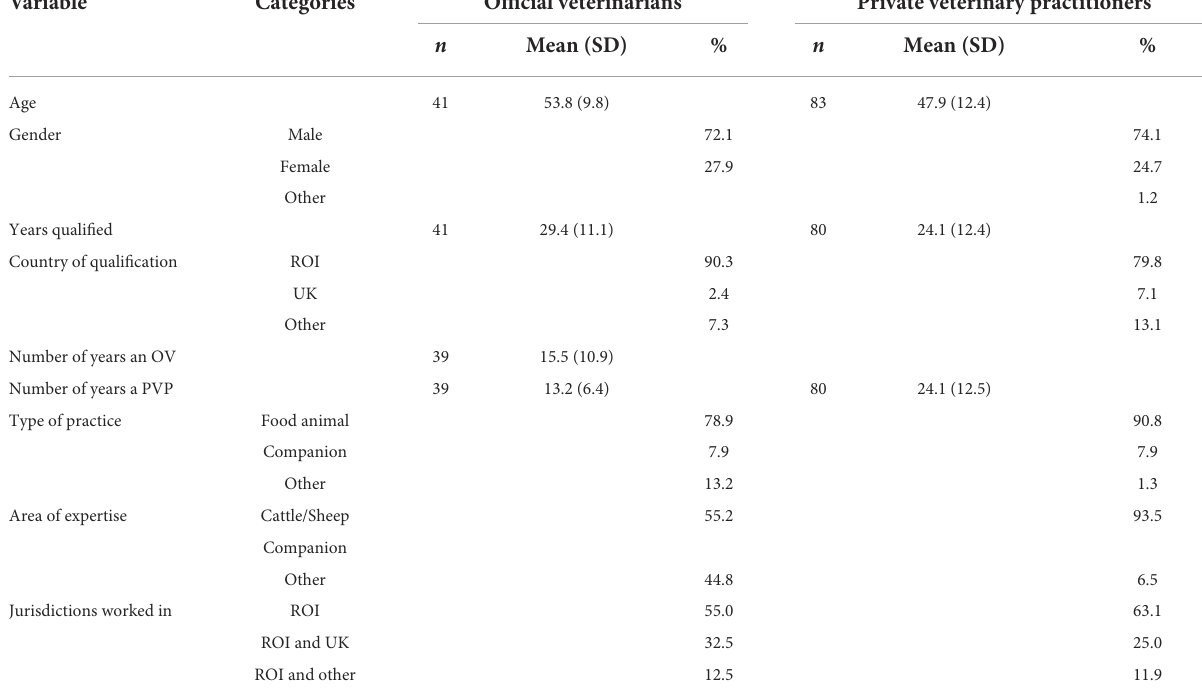
TABLE 1 Profile of Official Veterinarians and Private Veterinary Practitioners participants in the